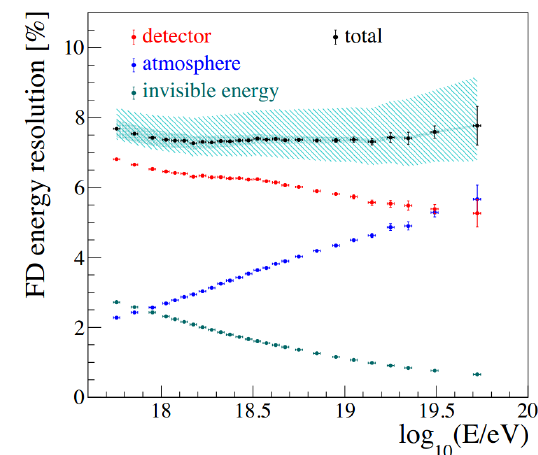
Figure 1. Energy resolution of the Fluorescence Detector for the hybrid data set. Contributions from the detector e ff ects (detec- tion and reconstruction), the atmosphere, and the correction for invisible energy are reported. Details are presented in Ref.